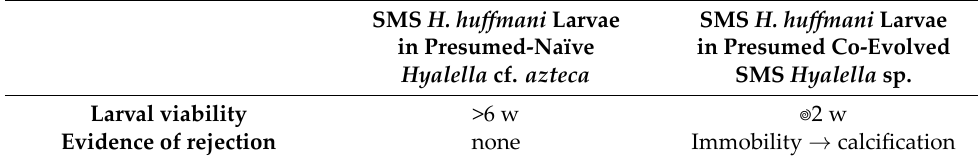
Differential reaction of the two SMS amphipod species to infection with eggs of local Huffmanela